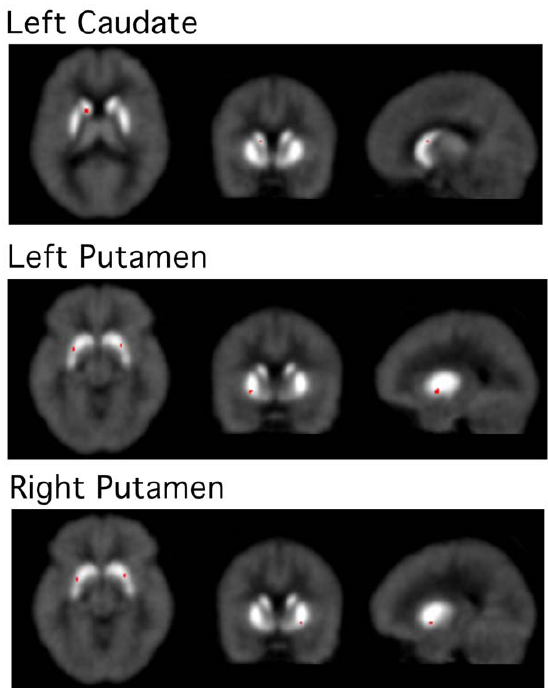
Figure 2. t-maps of D BP showing reduction in the ligand binding potential during task performance. The t-maps generat- ed using extended reference region tissue model (E-SRTM) show striatal areas where the ligand binding potential decreased significantly in the Incongruent condition in comparison with the Congruent condition. It was most significant in the left caudate and putamen. These areas are located in close proximity to the locations where increased rate of ligand displacement was observed (Figure 1). An agreement in the data computed using two different receptor kinetic models significantly enhances the reliability of